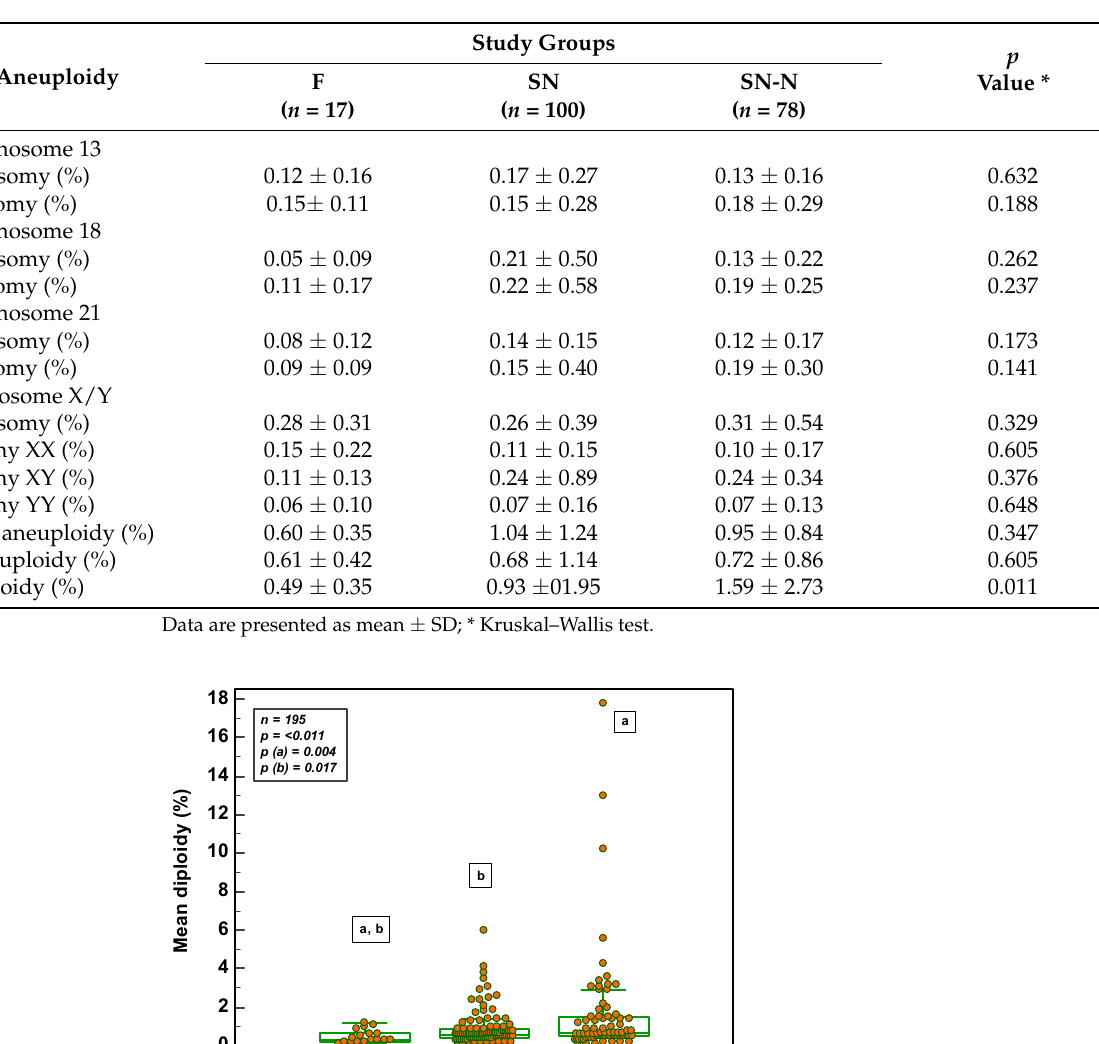
Figure 7. Frequency of aneuploidies after FISH analysis (SN = subfertile population with normozo- ospermia; SN-N = subfertile non-normozoospermic population). * Fischer’s exact test p = 0.0108.